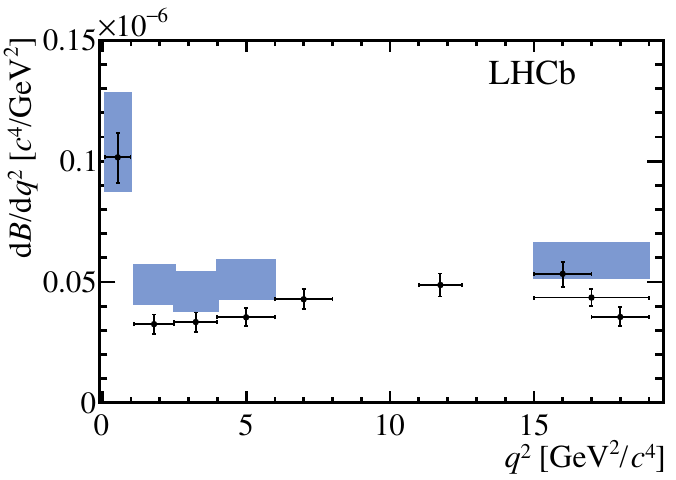
Figure 5 . Di(cid:11)erential branching fraction of B 0 ! K (cid:3) (892) 0 (cid:22) + (cid:22) (cid:0) decays as a function of q 2 . The data are overlaid with the SM prediction from refs. [47,48]. No SM prediction is included in the region close to the narrow c (cid:22) c resonances. The result in the wider q 2 bin 15 : 0 < q 2 < 19 : 0 GeV 2 =c 4 is also presented. The uncertainties shown are the quadratic sum of the statistical and system- atic uncertainties, and include the uncertainty on the B 0 ! J= K (cid:3) 0 and J= ! (cid:22) + (cid:22) (cid:0) branching fractions.